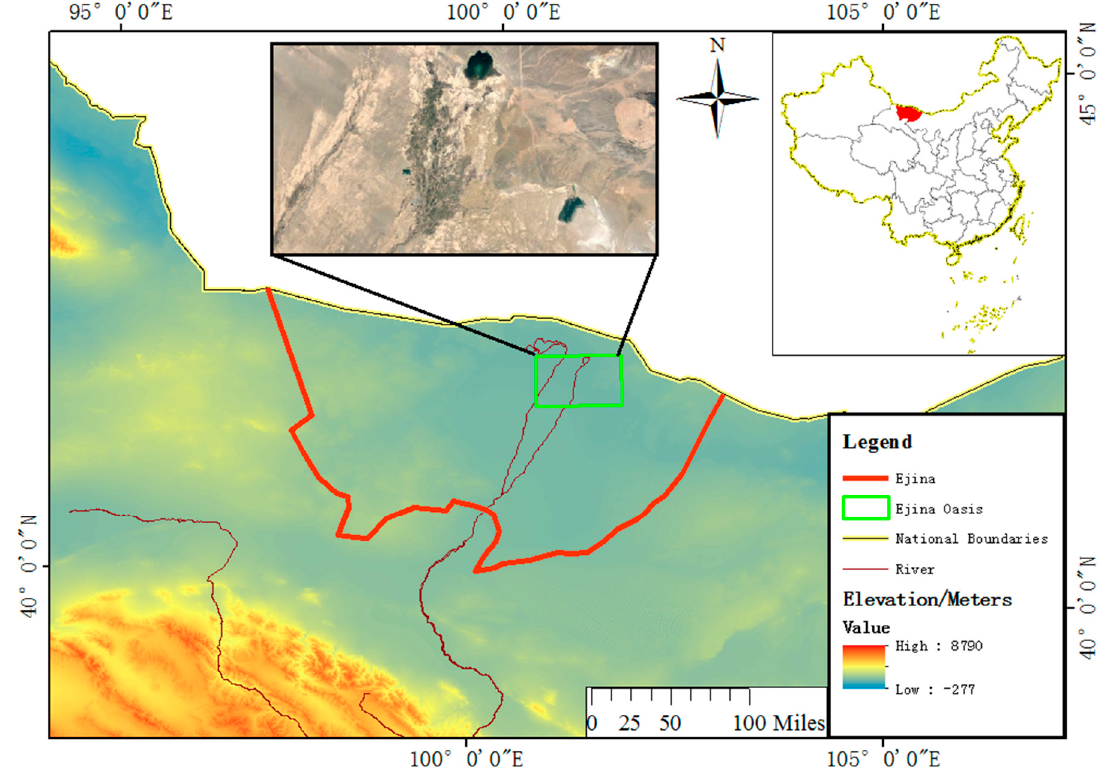
Figure 1. The study site and its geographical location. The zoomed-in figure of Ejina Oasis is a screenshot image. screenshot